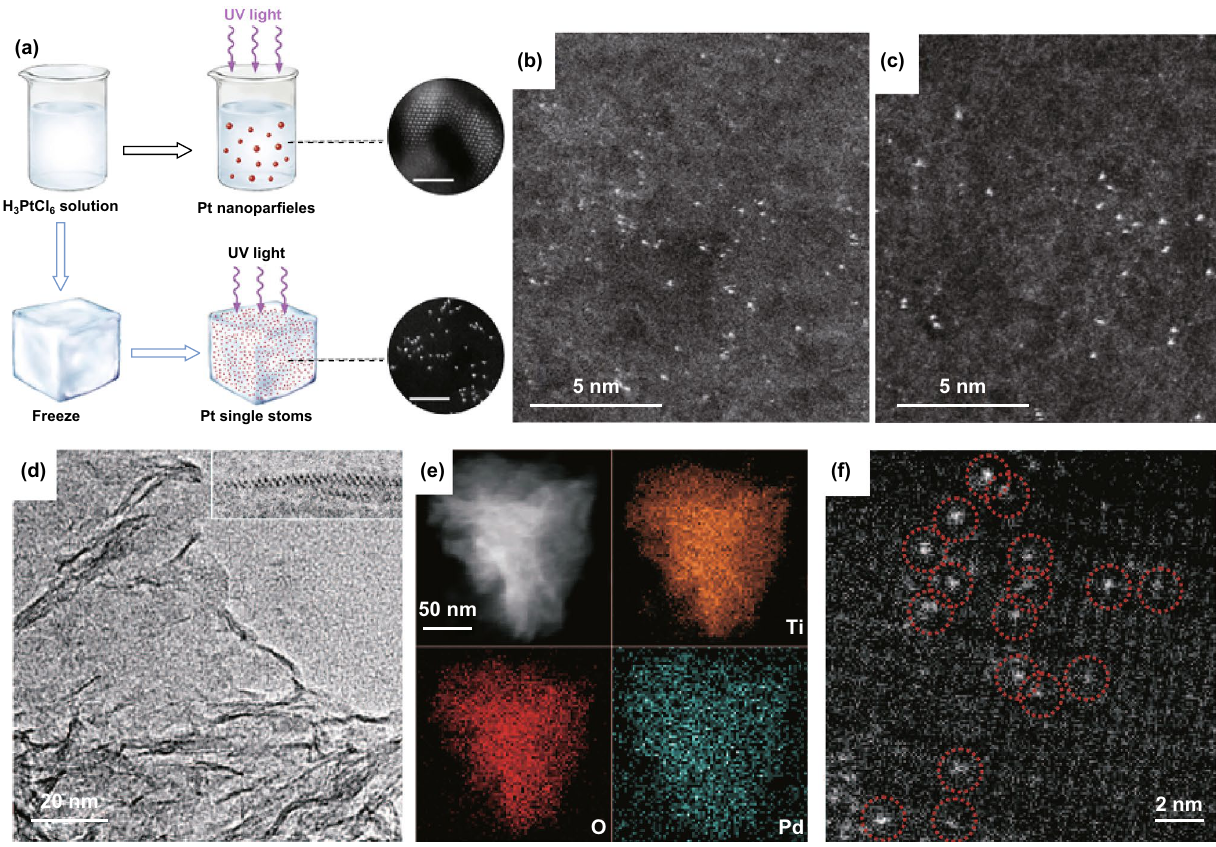
Fig. 7 a Schematic illustration of the iced photochemical process. AC-HAADF-STEM images of b Ag SACs and c Au SACs. d–f Structural characterizations of Pd 1 /TiO 2 . a–c Reproduced from Ref. [125] with permission. Copyright 2015, Royal Society of Chemistry. d – f Reproduced from Ref. [84] with permission. Copyright 2016